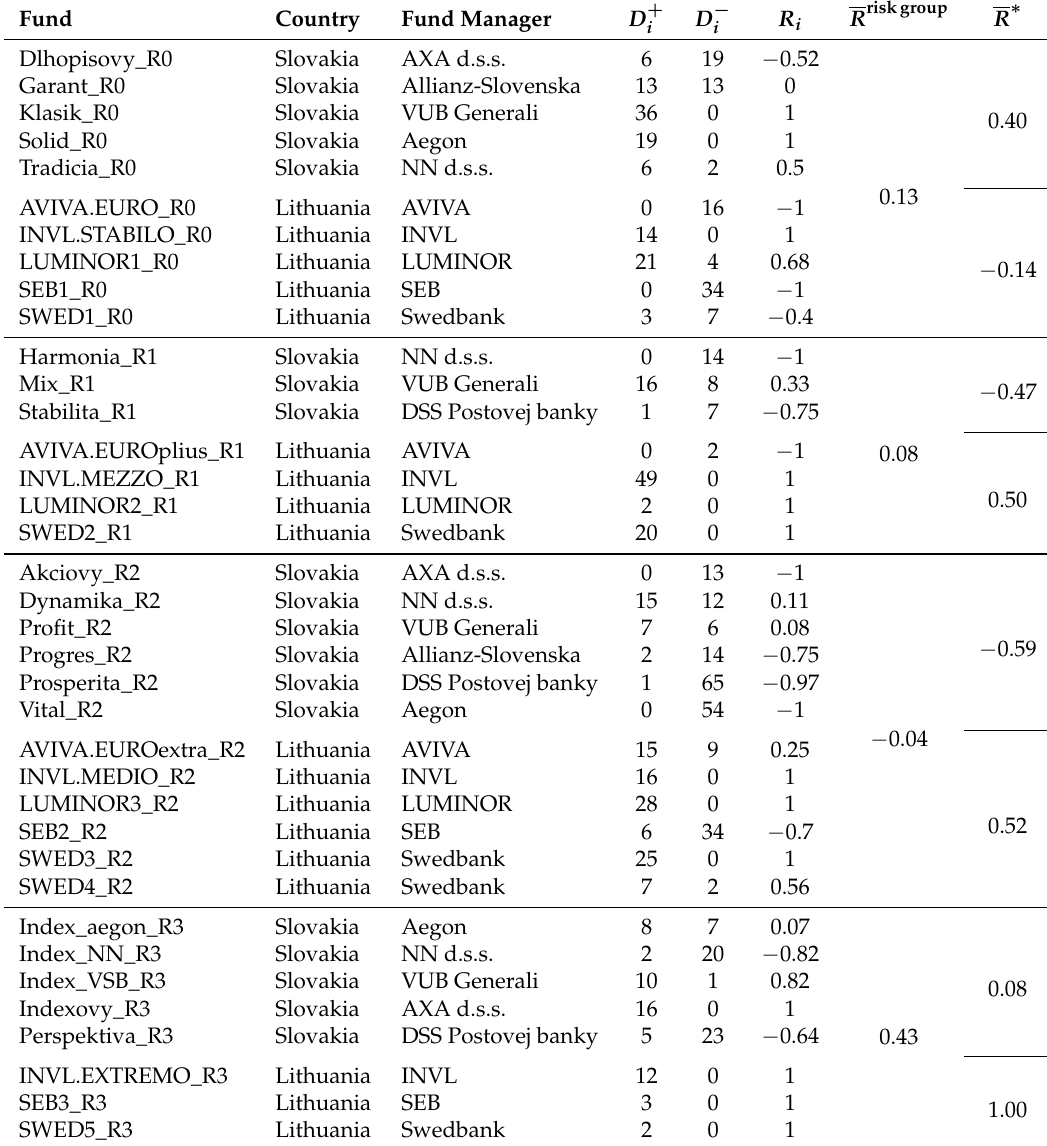
Table 4. The estimated stochastic dominance